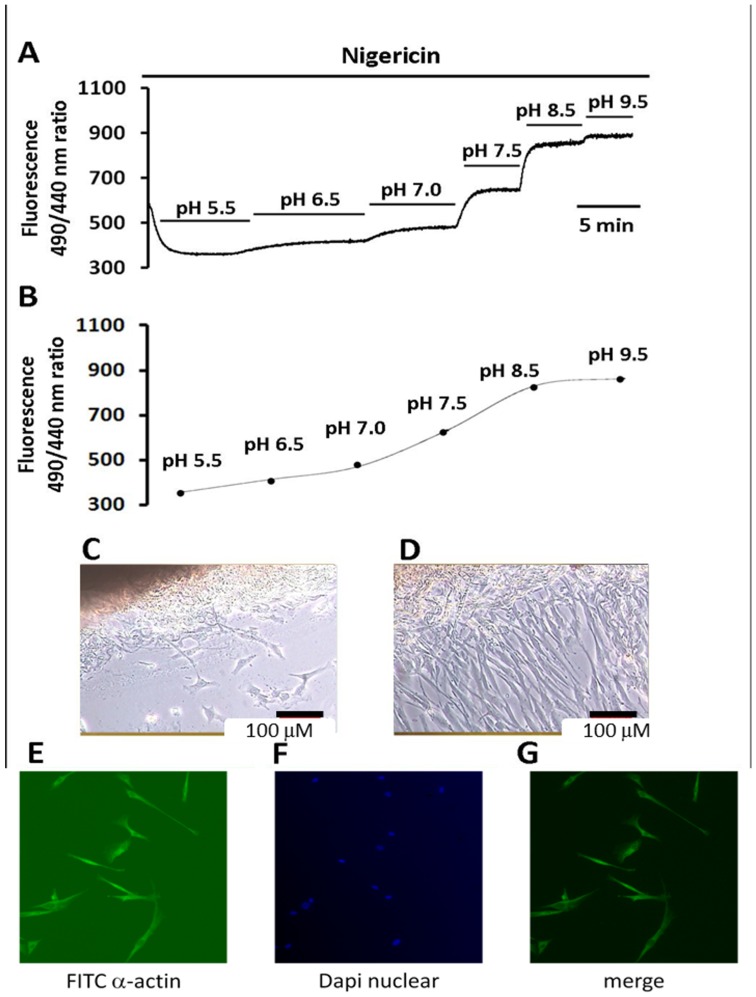
In situ calibration of intracellular pH, purity and identification of human renal artery smooth muscle cells.
A & B: In situ intracellular pH calibration curve in human renal artery smooth muscles cells (HRASMCs). A: The trace shows the BCECF fluorescence (510 nm emission at 490 nm and 440 nm excitations) in HRASMCs. (Please see Materials and Methods for details). B: The curve shows data pooled from 6 similar experiments shown in A. C & D: Phase-contrast micrographs of cultured HRASMCs (10×40), using explant technique. Cell cultured at the 10th day (C) and 20 days (D). The dark black area at the left top corner is the renal artery tissue. The bar below represents a length of 100 μm. E, F & G: Micrographs of immunohistochemistry of HRASMCs. E: HRASMCs stained for the anti-smooth muscle alpha actin (green). F: HRASMCs counterstained with DAPI for nuclei (blue). G: A merge micrograph that combines micrograph E and micrograph F (10×40).